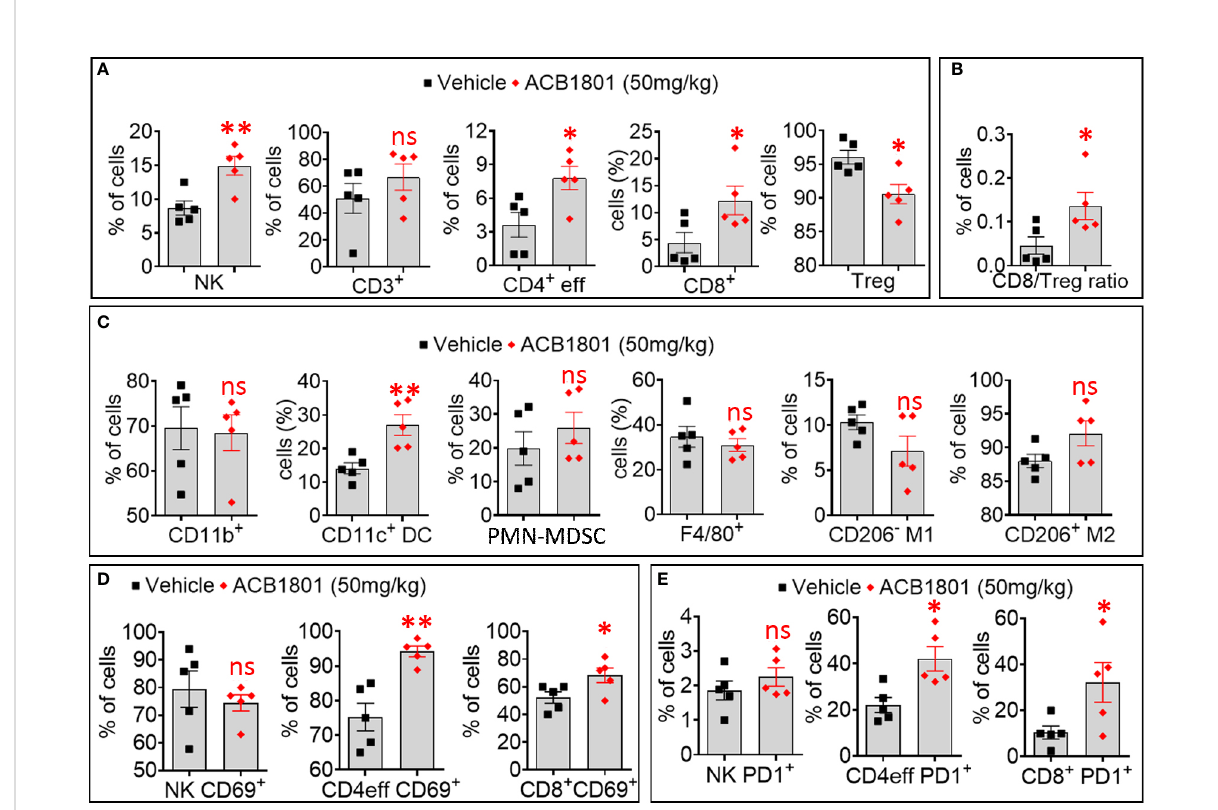
FIGURE 3 Treatment of B16-F10 tumor-bearing mice with ACB-1801 increases the in fi ltration of cytotoxic immune cells into the tumor microenvironment. (A) Flow cytometry quanti fi cation of the percent (%) live natural killer (NK) cells, CD3+, CD4+ effector T cells, CD8+ T cells, and regulatory T lymphocytes (Treg) in fi ltrating B16-F10 tumors treated treated with vehicle or 50 mg/kg of ACB-1801. (B) The ratio of CD8/ Treg reported as percent (%) of cells in fi ltrating B16-F10 tumors treated as described in (A) . (C) Flow cytometry quanti fi cation of the percent (%) of live myeloid cells (CD11b+), dendritic cells (DC), polymorphonuclear myeloid derived suppressor cells (PMN-MDSC), total macrophages (F4/ 80), M1 macrophages (CD206 - M1), and M2 macrophages (CD206 + M2) in fi ltrating B16-F10 tumors treated as described in (A) . (D, E) Flow cytometry quanti fi cation of the percent (%) of live CD69 + (D) , PD-1 + (E) NK cells, CD4+ effector T cells, and CD8+ T cells in fi ltrating B16-F10 tumors treated as described in (A). All quanti fi cations were performed on well-established tumors harvested at day 17. The immune cell populations were gated and quanti fi ed in live CD45+ cells. Each dot represents one tumor. Data are reported as the average of 5 mice per group as mean ± SEM (error bars). Statistically signi fi cant differences are calculated in comparison to vehicle-treated tumors using an unpaired two-tailed student ’ s t-test (ns, not signi fi cant, * =p< 0.05, and ** =p<